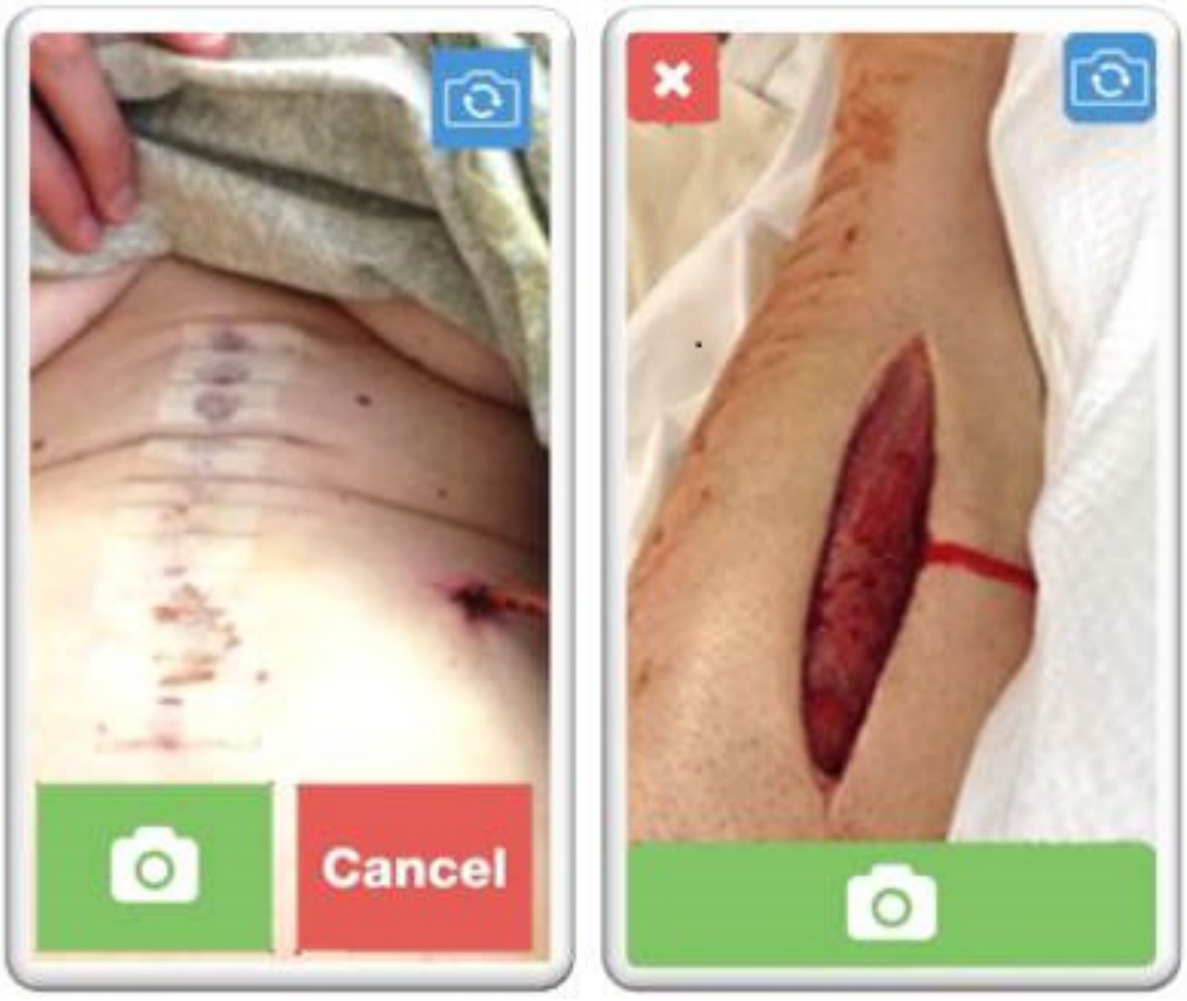
Figure 3. Original and modified image-taking screen. On the left is the original camera screen with both the image-capture and cancel buttons at the bottom of the screen. On the right is the modified screen based on user feedback. The image-capture button takes up the whole bottom of the screen, but does not extend as far up into the screen, and the cancel button has been moved away from it to decrease button